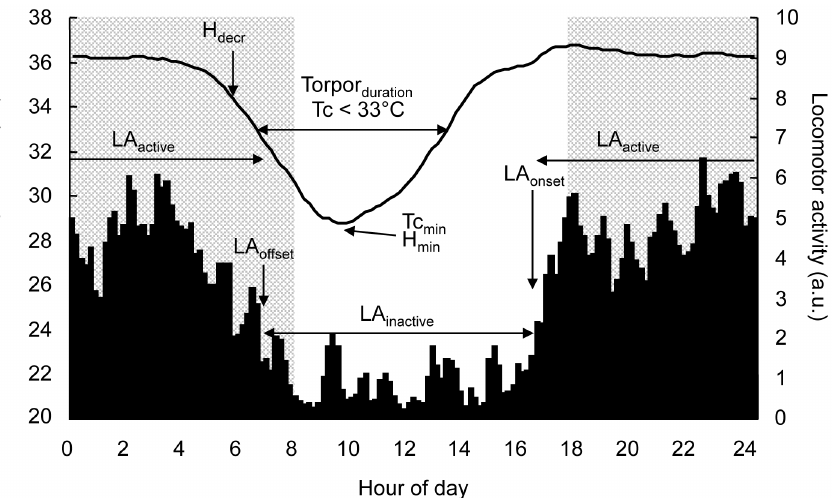
Figure 2. Parameters related to daily rhythms in Microcebusmurinus . Parameters used to characterize daily rhythms of locomotor activity (LA – arbitrary units) and core temperature (Tc) in mouse lemurs during short-days photoperiod. The night period is indicated by the grey